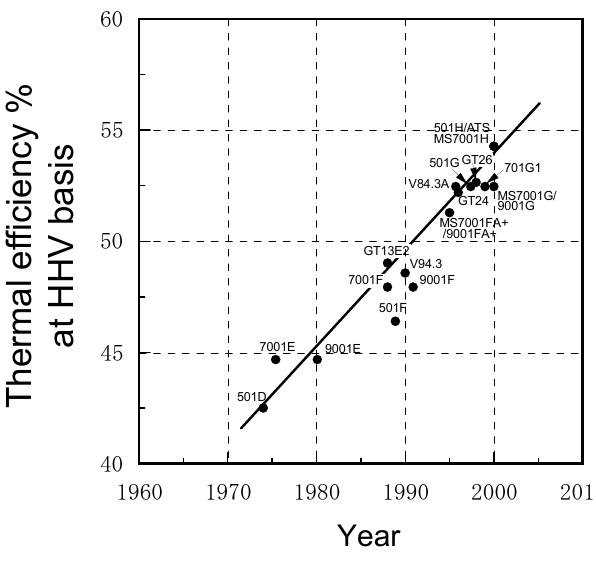
Figure 7. Transition of thermal efficiency of gas turbine combined cycle power plant. (Signs indicate names of gas turbine